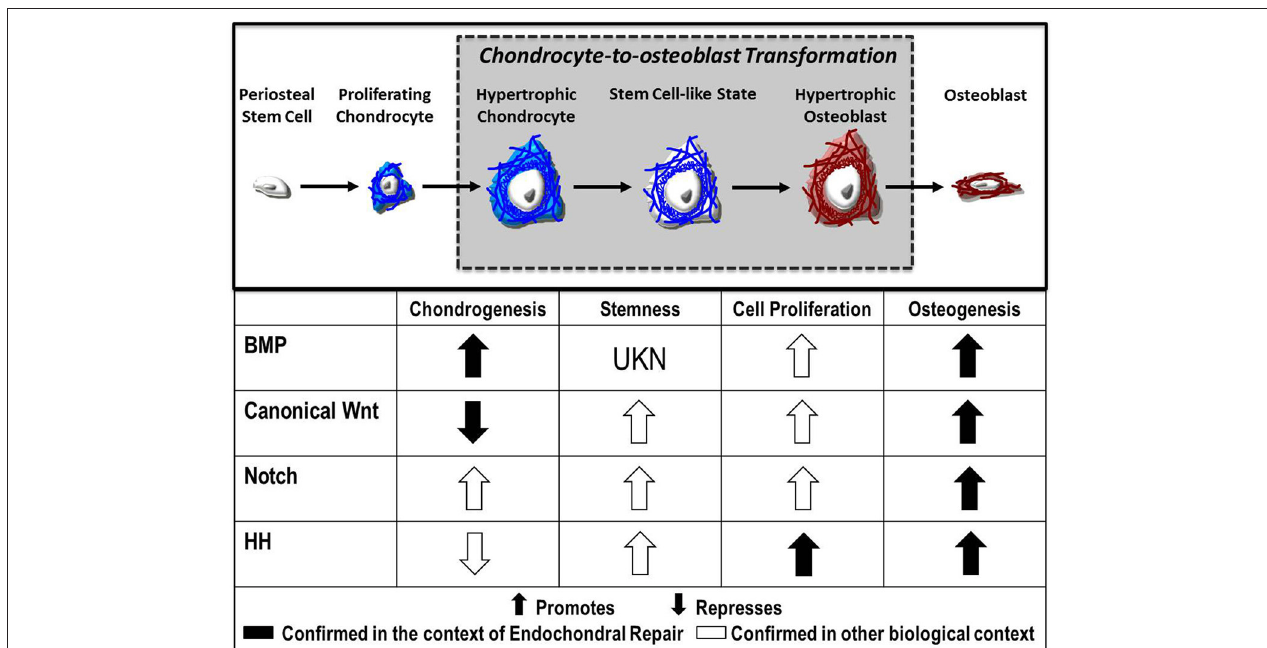
FIGURE 2 | Fate of the chondrocyte. During endochondral ossification, the formation of the cartilage callus begins with the differentiation of periosteal stem cells into chondrocytes, which proliferate and mature to a hypertrophic state. These hypertrophic chondrocytes then re-enter the cell cycle, express stem cell markers, and finally transform into osteoblasts that contribute to the formation of new bone. Published evidence suggests the Bone Morphogenetic Protein (BMP), Canonical Wnt, Notch, and Hedgehog (HH) pathways as candidate regulators of chondrocyte-to-osteoblast transformation due to their effects on chondrogenesis, stemness, cell proliferation, and osteogenesis in the context of endochondral repair ( ) and in other biological contexts (